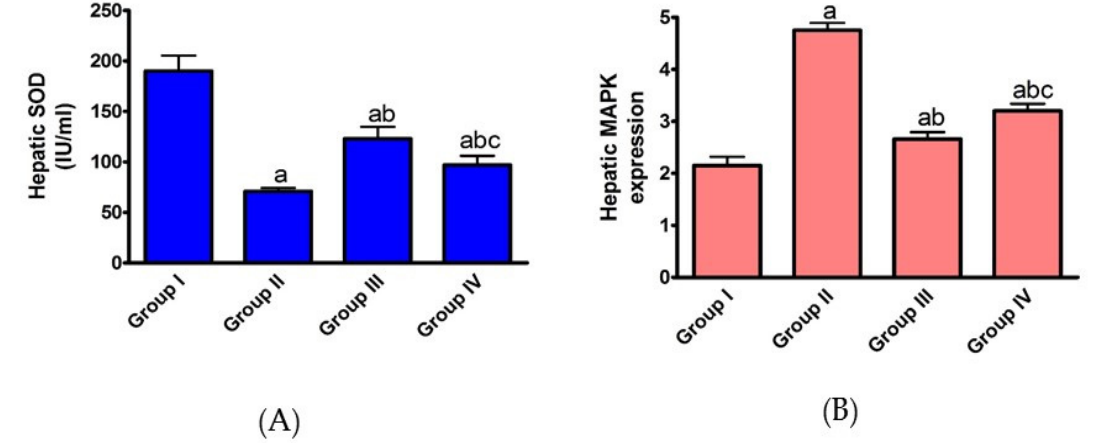
Figure 2. Effect of carvedilol on hepatic ( A ) SOD and ( B ) MAPK expression in hepatic ischemia- associated isoprenaline-induced AHF in male Westar rats. Group I: naïve group, Group II: control positive, Group III: carvedilol pre-treated, Group IV: carvedilol post-treated. Data presented as mean ± SEM. a p < 0.05 versus group I, b p < 0.05 versus group II, c p < 0.05 versus group III.